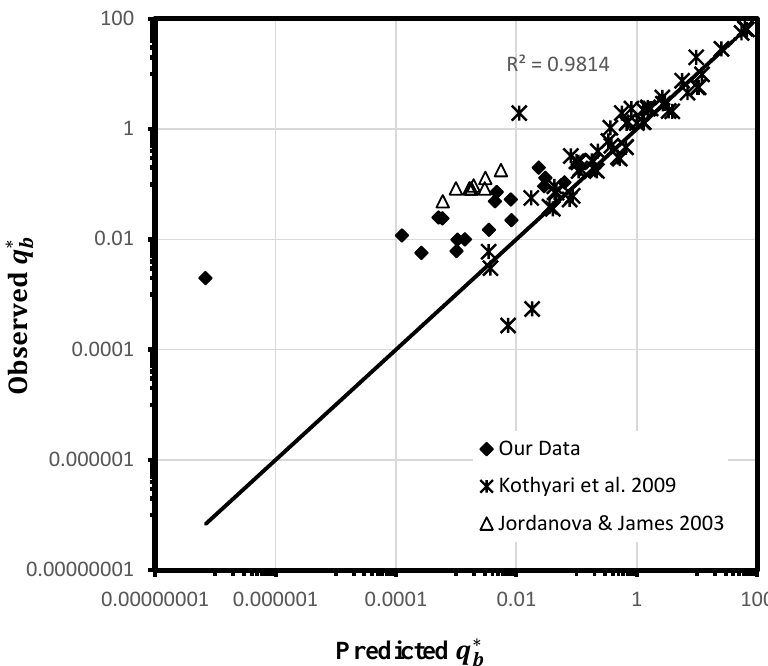
Figure 10. Scatter plot for predicted and observed values of 𝑞 𝑏∗ based on optimum parameter set [11, 12].